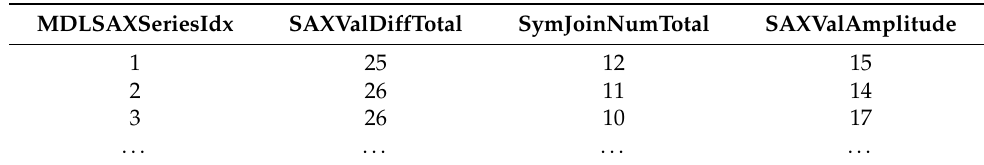
Table 2. Sample extract of volatility table details from MDL-SAX table.